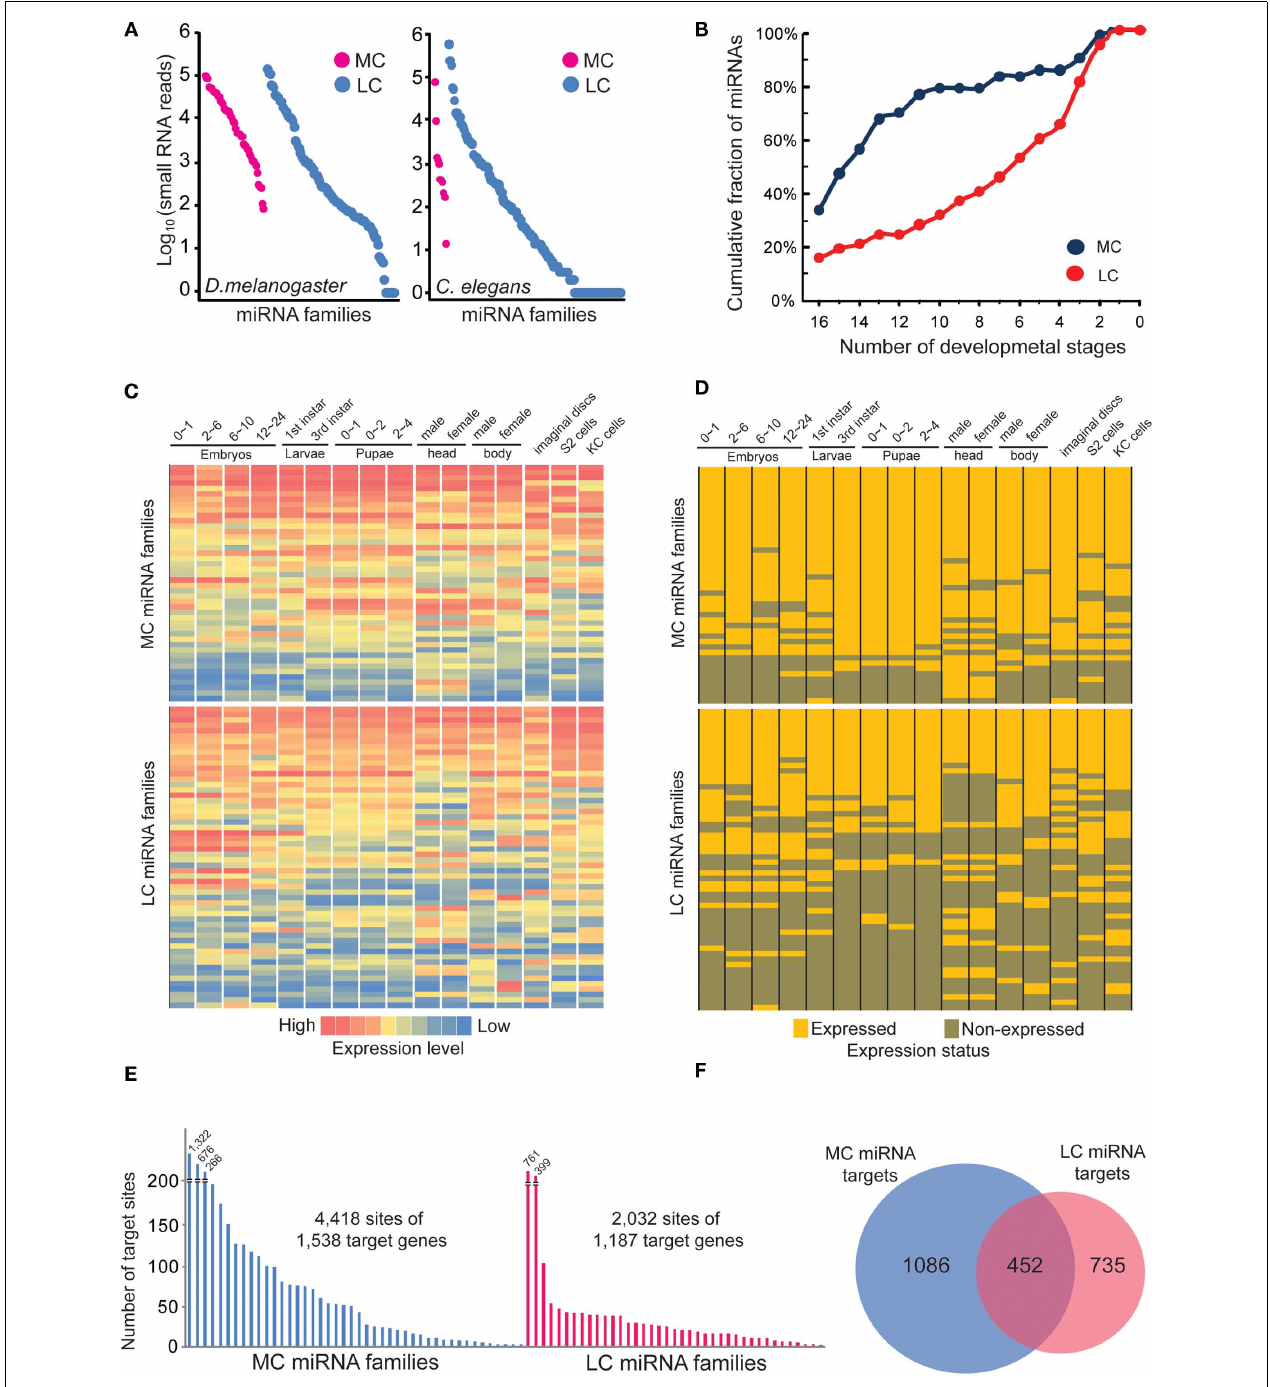
miRNA expression abundances were normalized. (D) The binary expression status of D. melanogaster MC and LC miRNA families across different developmental stages. (E) The MC miRNAs in D. melanogaster have more predicted target sites than LC miRNAs. In this analysis, we selected the top 30 MC and top 30 LC miRNAs whose abundances are over 1,000 smRNA-seq reads. (F) Only 20% of the total targets of MC and LC miRNAs are